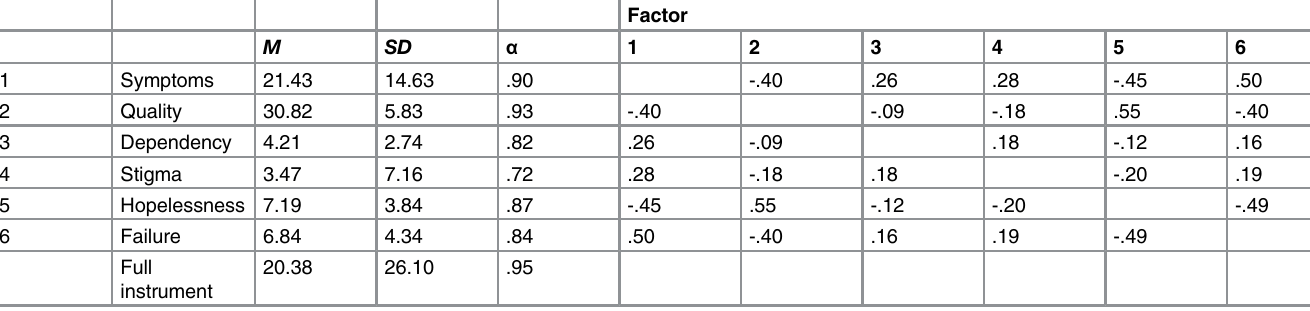
Table 4. Means, standard deviations, internal consistencies, and correlates among the obtained